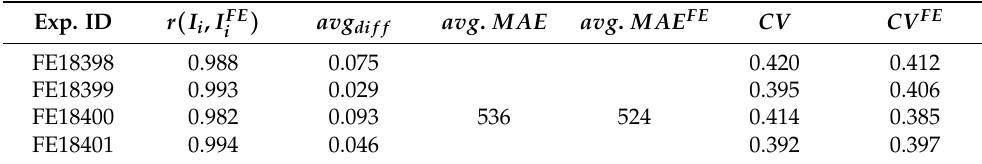
Table 1. Evaluation of the image registration and segmentation accuracy.